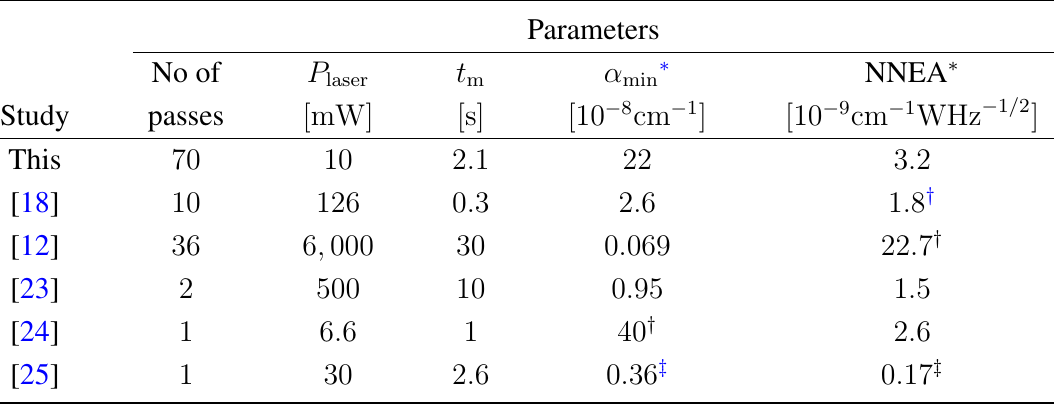
Table 1. Comparison of PA methods with different number of optical passes in PA cell. P , t , (cid:11) , and NNEA are the average laser power, measurement time, minimum laser m min detectable absorption coefficient, and normalized noise-equivalent absorption,